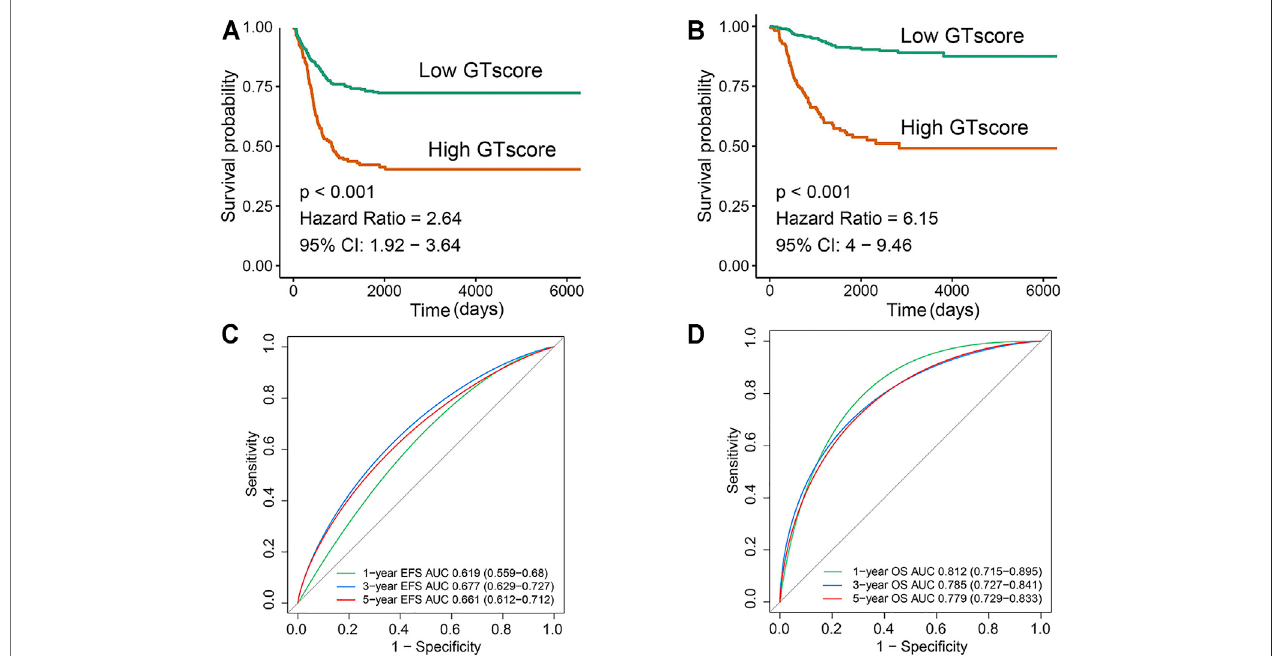
FIGURE4| ValidationoftheprognosticvalueoftheGTscoreforNBpatientsinthetrainingset.Kaplan – MeieranalysisforEFS (A) and OS (B) ofNBpatientsbased on the risk strati fi cation. ROC analysis for 1-, 3-, and 5-year EFS (C) and OS (D) prediction in NB patients. The AUCs at 1, 3, and 5 years were calculated to assess the predictive